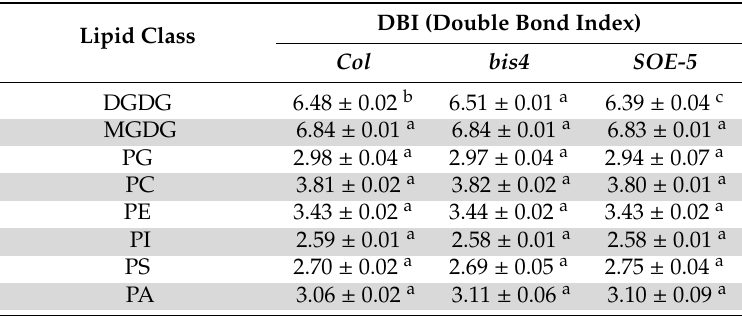
Table 3. Double bond index (DBI) of each lipid